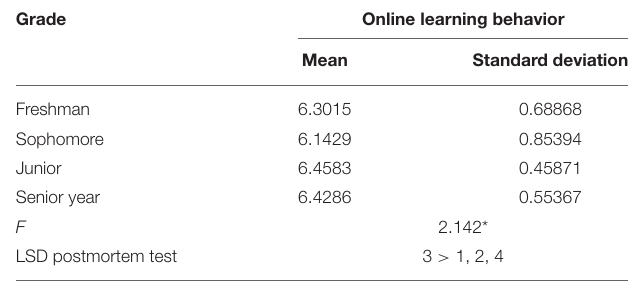
TABLE 4 | ANOVA test of grade in online learning